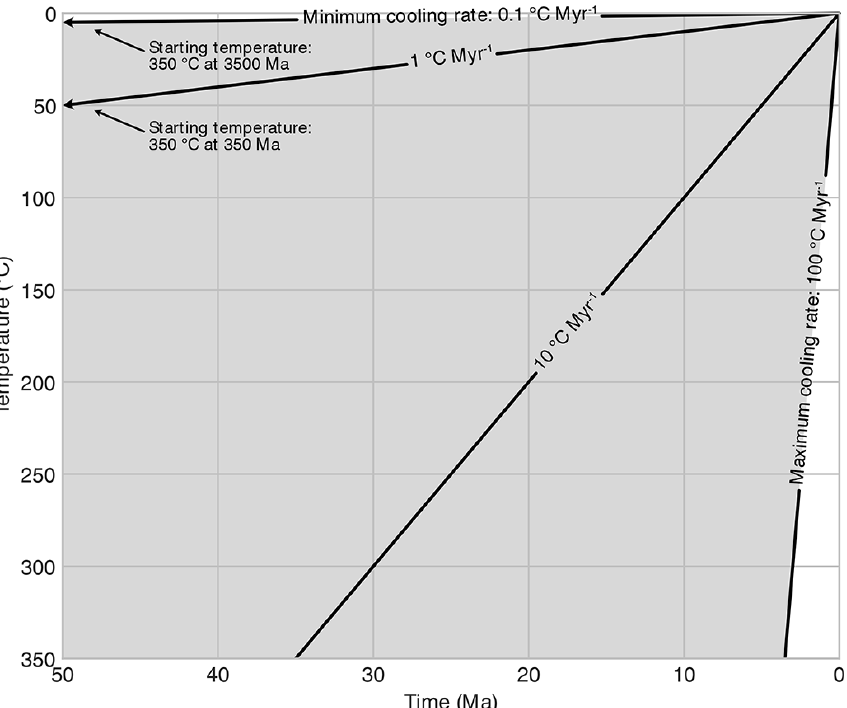
Figure 1. Temperature–time plot showing the range of cooling histories (grey-shaded area) used for thermochronometer age prediction. All scenarios start at 350 ◦ C and cool to 0 ◦ C at a constant rate. Note that the x axis of the plot is truncated for readability. Figure 2 shows results for a 10 ◦ CMyr − 1 cooling rate, Fig. 3 uses a 1 ◦ CMyr − 1 cooling rate, and Figs. 4 and 5 show results for the full shaded region in log